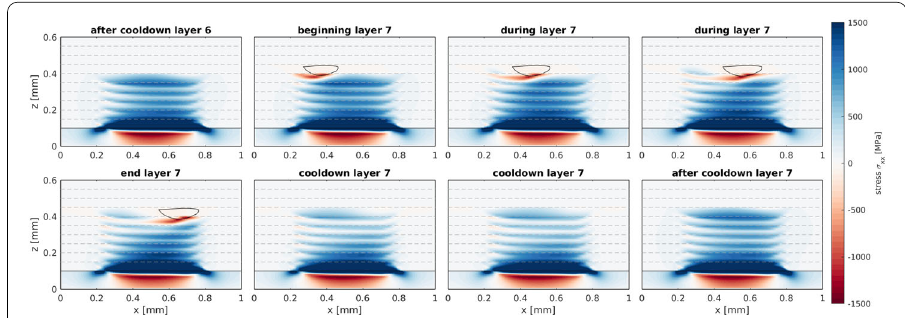
Fig. 18 Unidirectional scanning pattern: detailed view of the evolution of the longitudinal stress σ xx in the symmetry plane during scanning of layer 7. Blue color represents tension, red color represents compression. Liquidus isotherm (solid black line) approximates melt pool shape. Time progresses from left to right and top to bottom. For improved visibility of the relevant stresses the color bar is rescaled